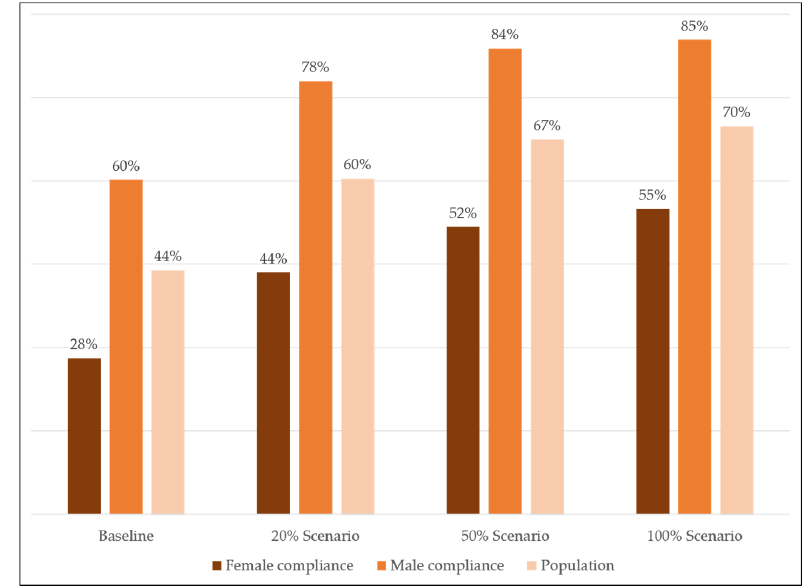
Figure 3. Proportions of Dutch adult men and women compliant with WHO potassium guideline at baseline and after each reformulation scenario.